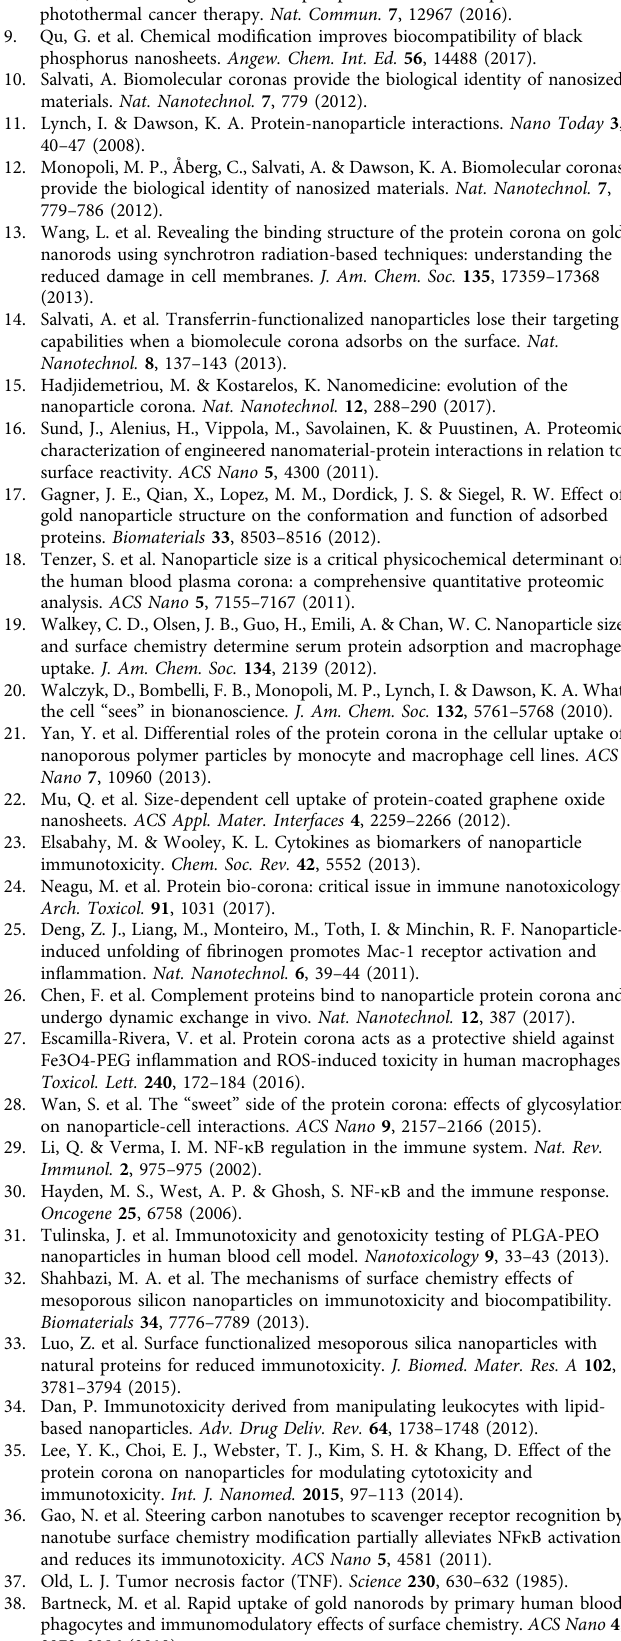
Supplementary Figure 12. The sources of primary antibody against the following protein were: β -actin (A1978, 1:10,000 for WB) from sigma; p65 in nuclear (ab16502, 1:1000 for WB), and l κ B (15095, 1:1000 for WB) from Abcam. The appropriate secondary antibodies (1:10,000 for WB) were purchased from Abcam. Statistical analysis . All the data are expressed as mean± standard deviation. Differences between different experimental groups were analysed by two-tailed Student ’ s t test. One-way analysis of variance was used in multiple group com- parisons. Statistical analysis was performed using SPSS statistical program